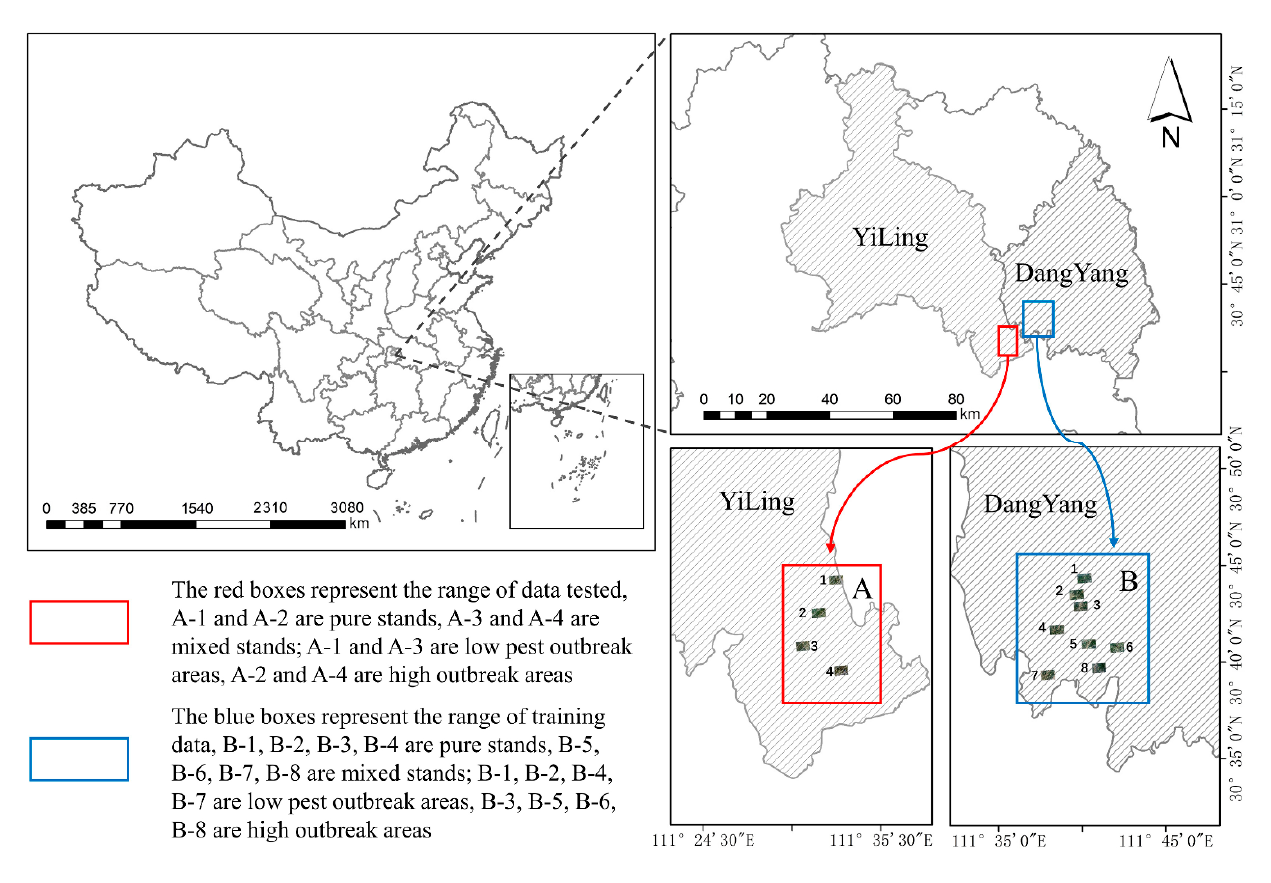
Figure 1. Localization of the study areas (A and B). Training and testing areas are labeled with different colors (blue for training and red for testing). Table 1. Statistical information of standing dead trees in site A.